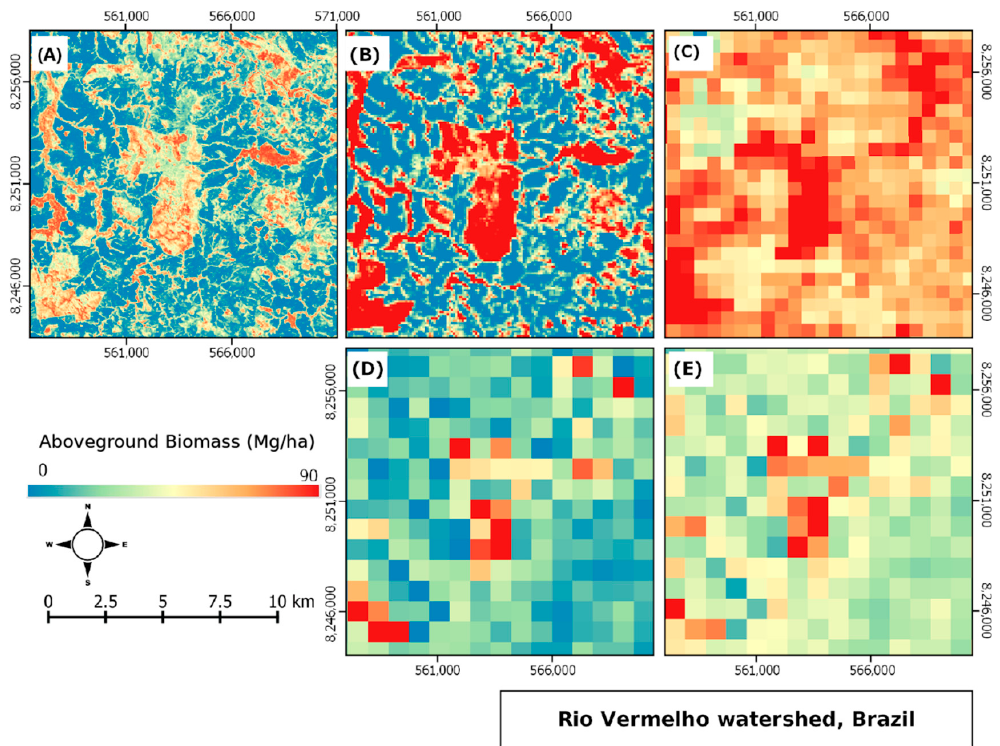
Figure 8. AGB maps over part of the Rio Vermelho watershed, Goiás State, Brazil produced by this study (30 m) ( A ) and by Santoro et al. [81] (100 m) ( B ), Baccini et al. [23] (500 m) ( C ), Avitabile et al. [22] (1 km) ( D ), and Saatchi et al. [21] (1 km) ( E ).